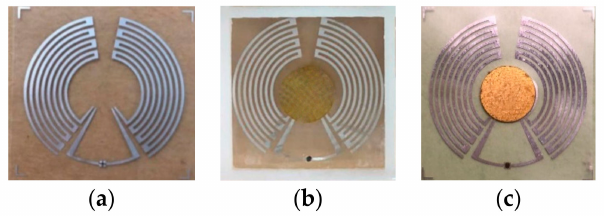
Figure 11. Photographs of the ( a ) disconnected tag, ( b ) finished finger-controlled tag, and ( c ) tag for impedance measurement.